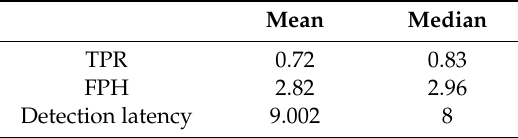
Table 4. Overall temporal performance.